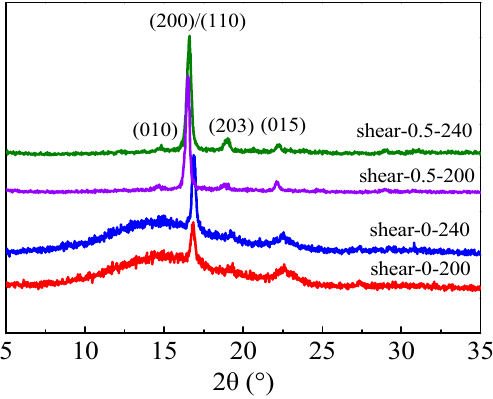
Figure 7. X-ray diffraction patterns of the PLLA/OXA-200 and PLLA/OXA-240 samples with and without a shear flow (0.4 rad/s for 5 s) at 155 °C. The samples were taken after the rheology measurements.